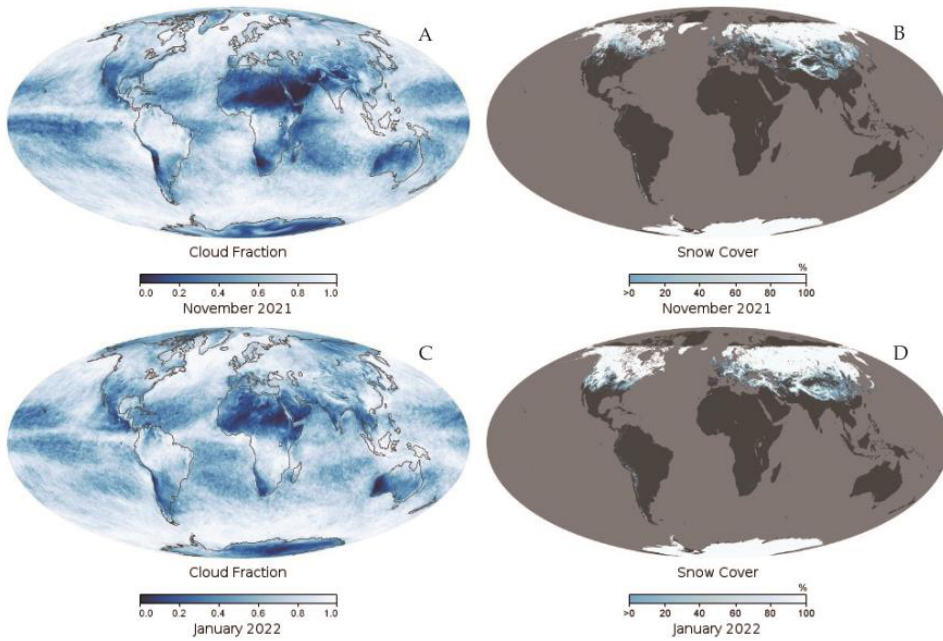
Figure 1. Global cloud cover ( A , C ) vs. snow cover ( B , D ) in November 2021 and January 2022.